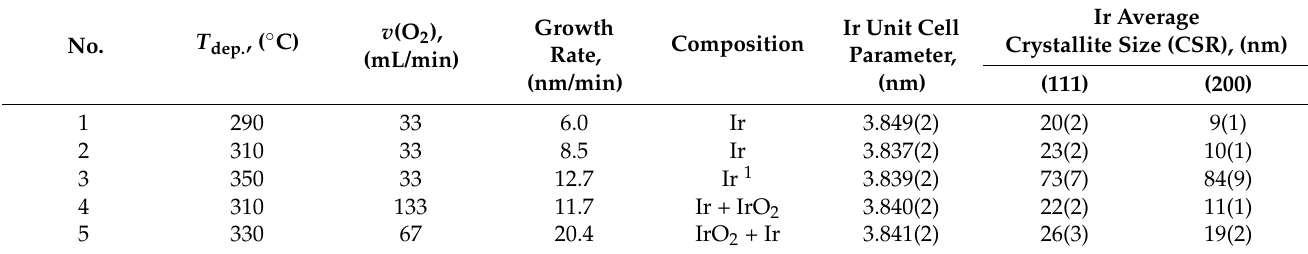
Table 1. Deposition conditions, growth rate, and results of XRD study of samples of iridium coatings on Si (100).